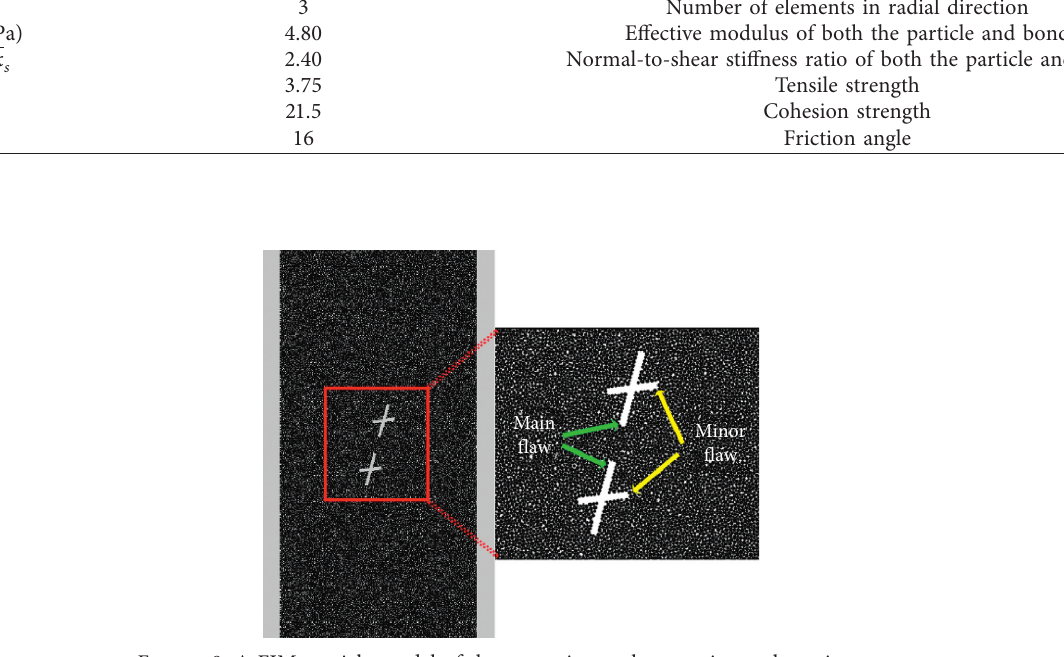
Figure 8: A FJM particle model of the same size as the experimental specimens.